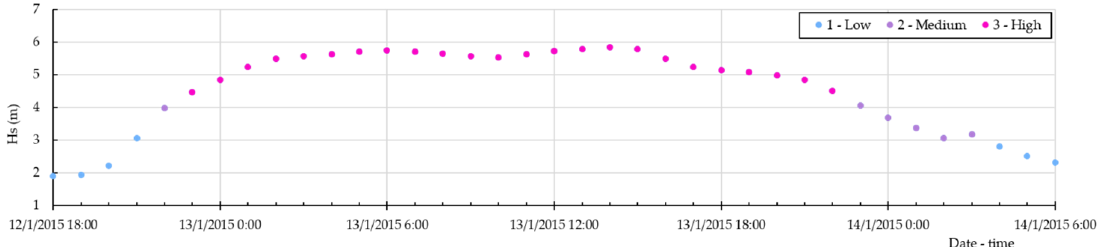
Figure 13. Coastal flood-risk levels in the parking area as predicted retrospectively by the developed ANN for the past flooding event S4 (occurred on 13 January 2015) in relation to offshore wave heights obtained from the open databases. Light blue dots represent a low-risk level, purple represent a medium-risk level and pink represent a high-risk